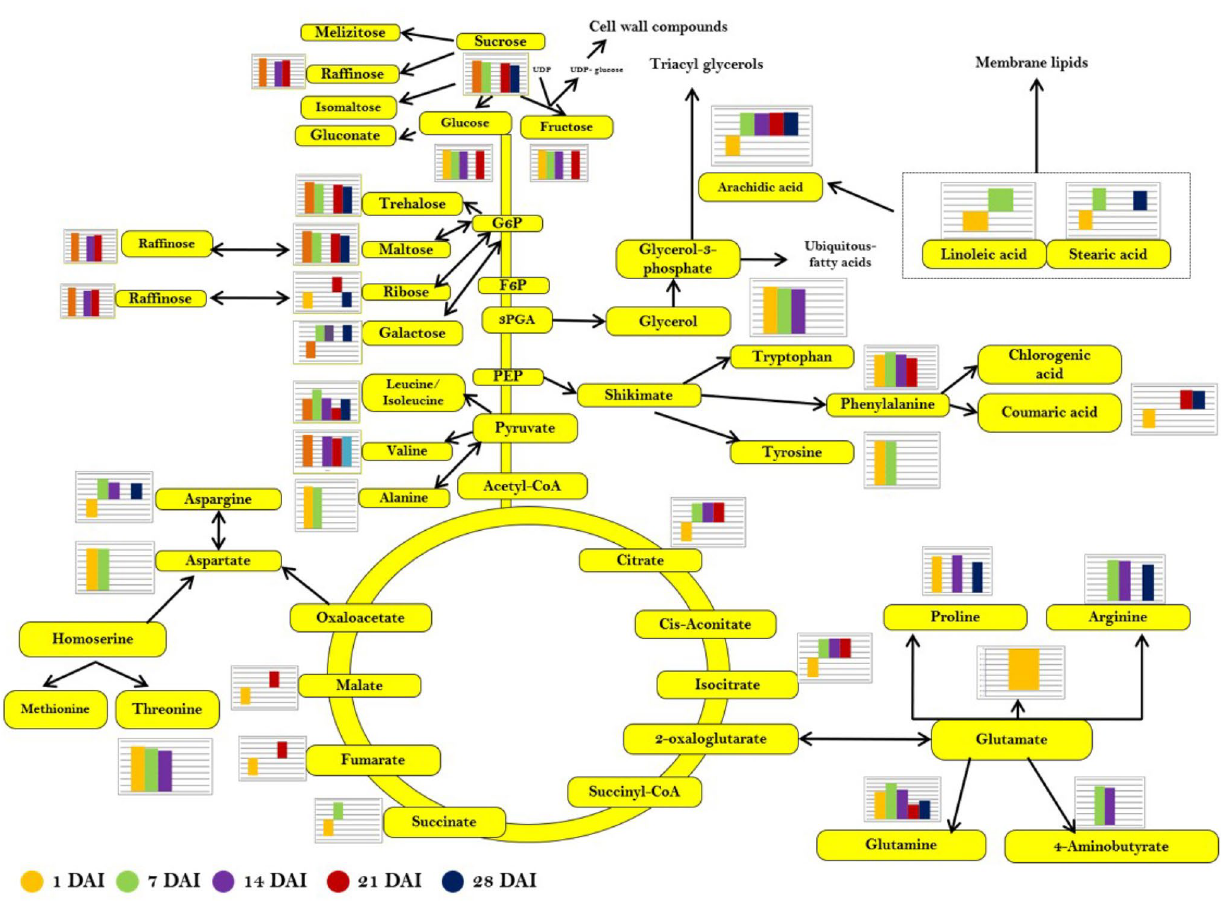
Figure 7. Comprehensive metabolic map of primary metabolites and associated secondary metabolites detected in the study during different developmental stages in laser-irradiated seeds and seedlings (1–28